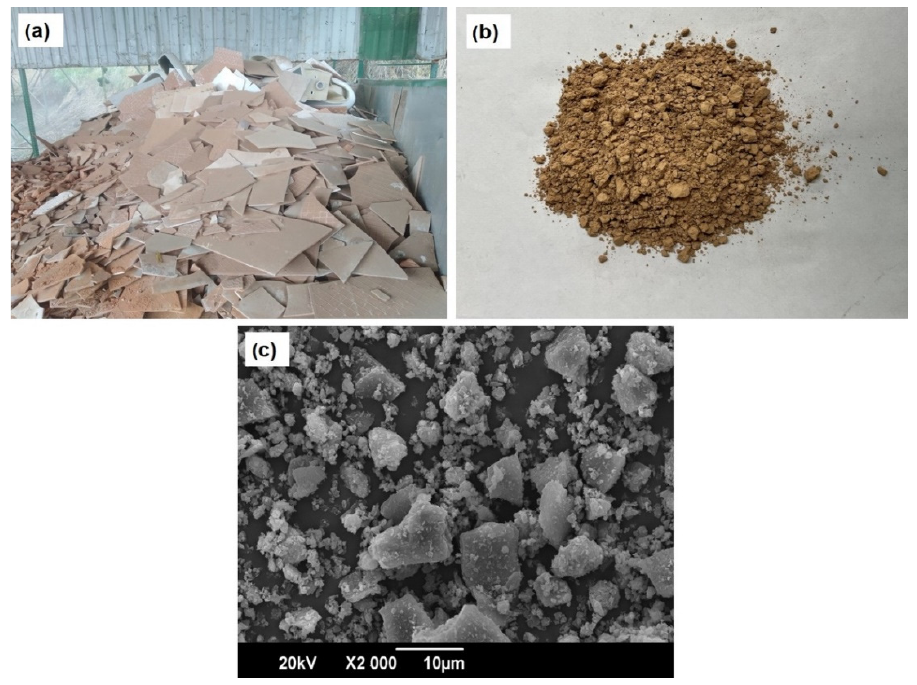
Figure 1. Ceramic tile wastes (CW): ( a ) before crushing, ( b ) after crushing, and grinding ( c ) SEM image.